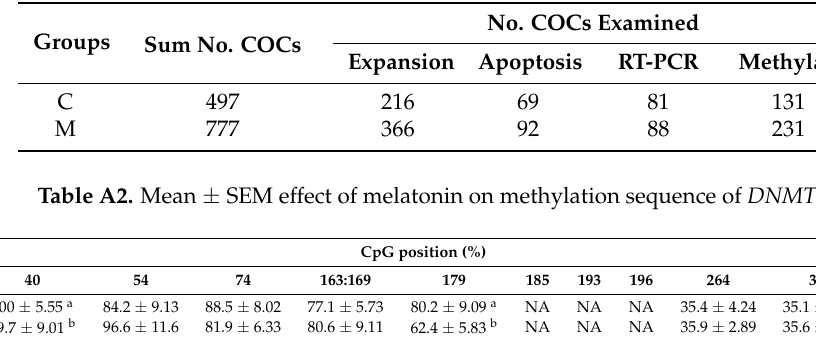
Table A2. Mean ± SEM effect of melatonin on methylation sequence of DNMT1 .